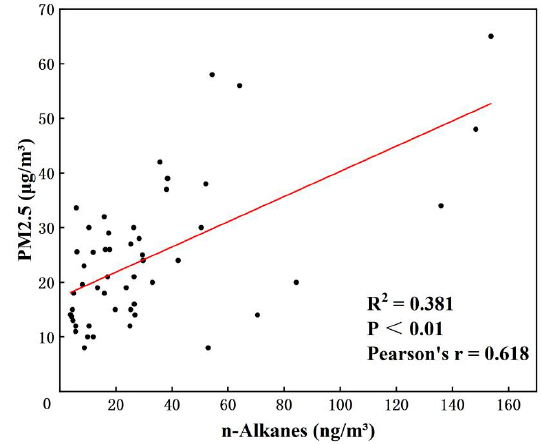
Figure 2. Association between particulate-bound n -alkanes and PM 2 . 5 in